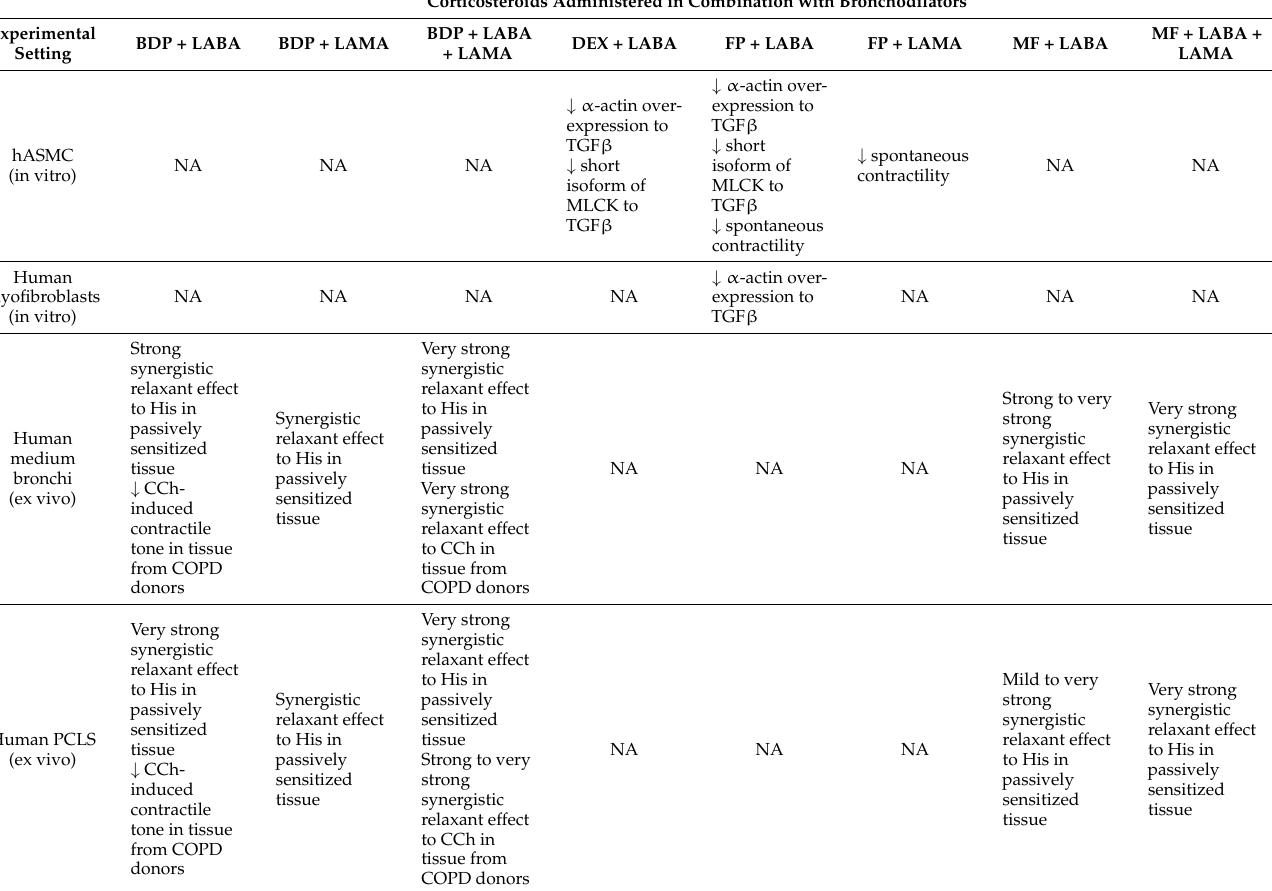
Table 3. Statistically significant ( p < 0.05) effects of specific CS administered in dual and triple combinations with bronchodilators against human ASM contractility and AHR in vitro and ex vivo studies as resulting from this systematic